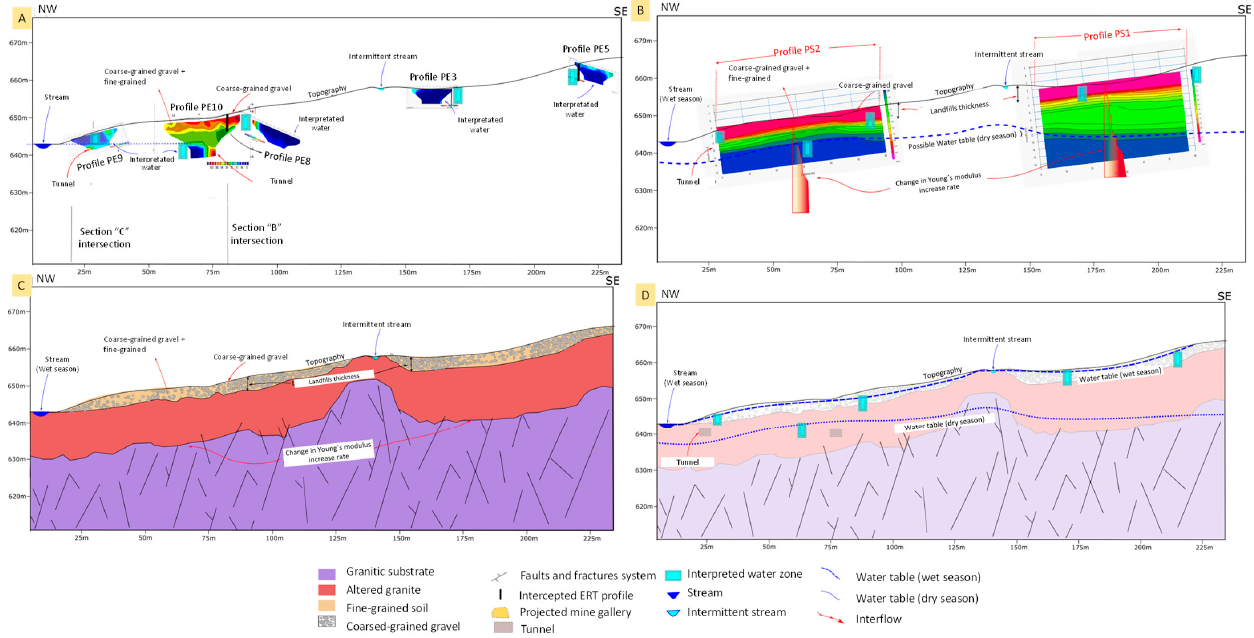
Figure 12. Hydrogeological interpretation process in Section “D” (see map location in Figure 9): ( A ) Data used and calibrated with surface observations (ERT profiles); ( B ) Seismic profiles results for PS1 and PS2 profiles (2D “p” wave velocity model and average Young’s Modulus E); ( C ) Geological interpretation; ( D ) Hydrogeological interpretation.